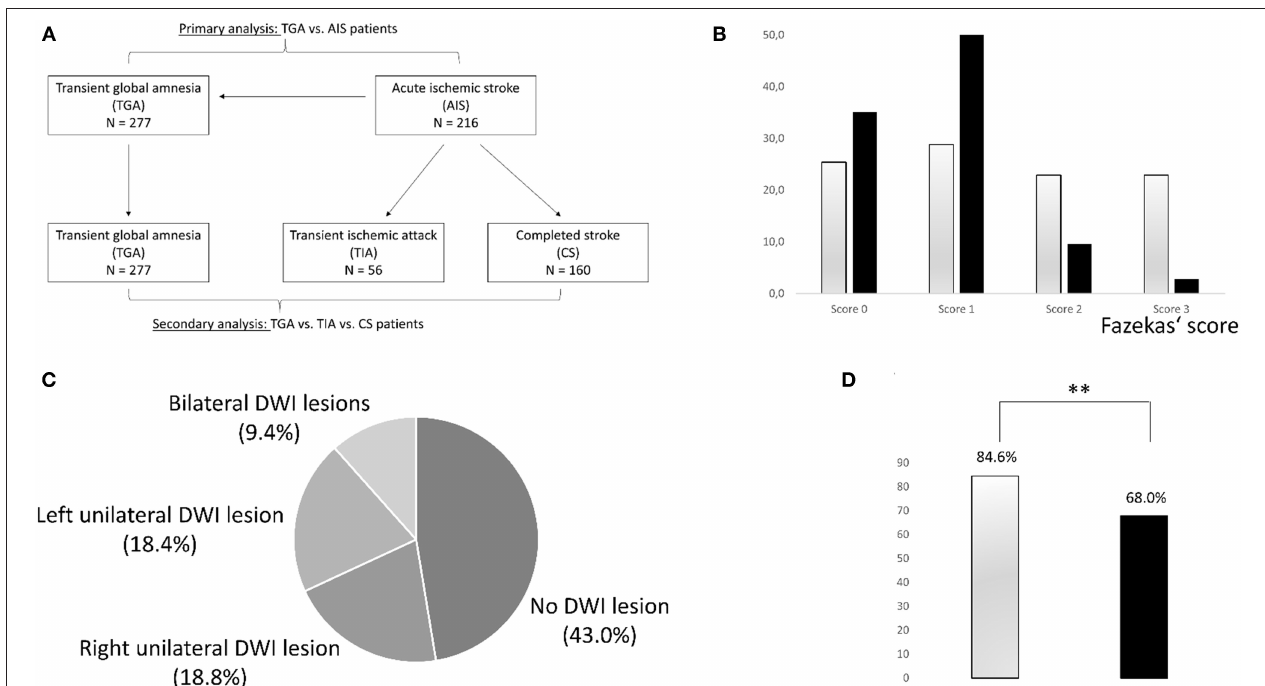
FIGURE 1 | (A) Presentation of patient groups and analyses. (B) Severity distribution of cerebral microangiopathy using Fazekas’ score in patients with stroke (gray) and TGA (black). Patients with TGA are more likely to have no or mild microangiopathy, while moderate or severe microangiopathy is more common in stroke patients. (C) Distribution of hippocampal DWI lesions in patients with TGA. (D) Presence of septal hypertrophy in transthoracic echocardiography as a potential sign of chronic hypertension in patients with AIS (gray bar) vs. TGA patients (black bar). Patients with AIS displayed septal hypertrophy more frequently (** p <